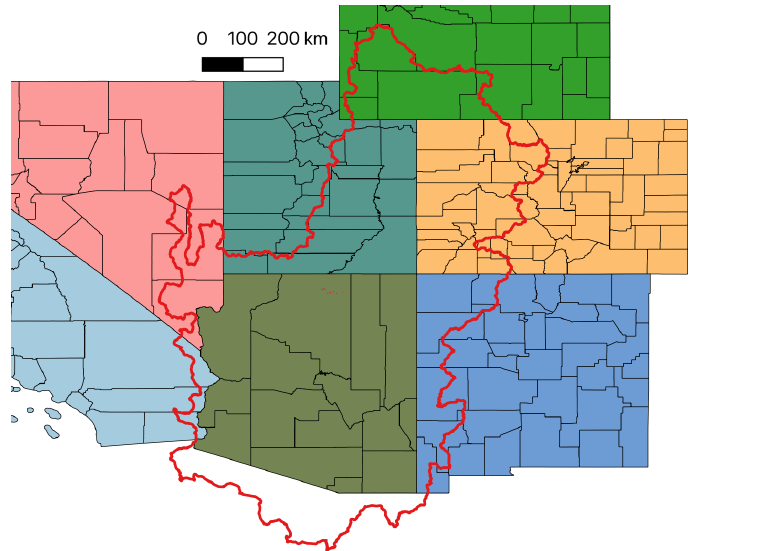
Figure 2. The Colorado river basin and main human scales. U.S. Census counties (represented in black) and states (from left to right, from bottom to top: California in light blue, Arizona in olive, New Mexico in blue, Nevada in pink, Utah in dark green, Colorado in orange, and Wyoming in green) intersecting CRB (represented in red—U.S. Census 2010 boundaries